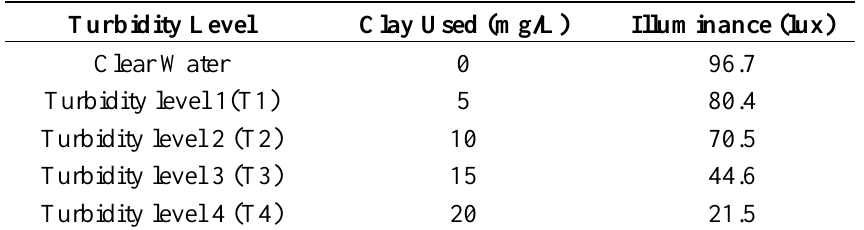
Table 1. Measurements of the turbidity